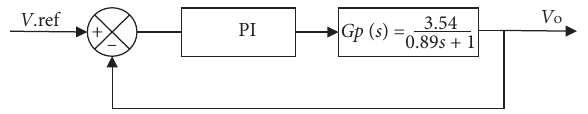
Figure 6: Closed-loop control of the first-order system.